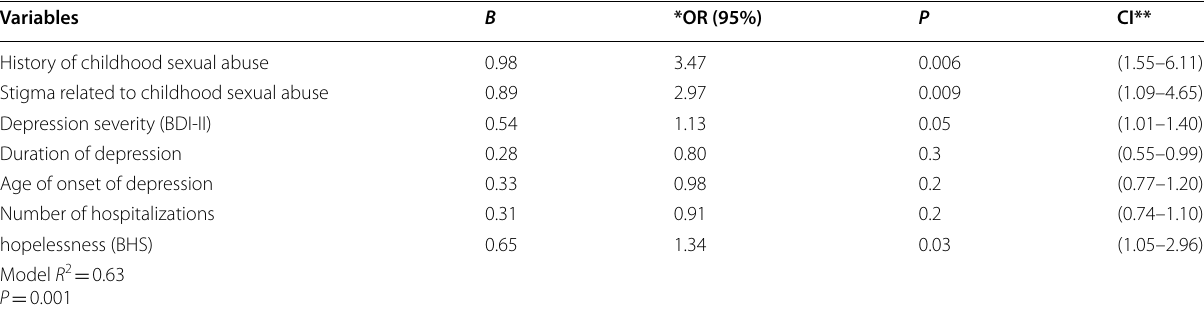
Table 3 Logistic regression model for variables predicting the presence of current suicidal ideations in depressed women (No